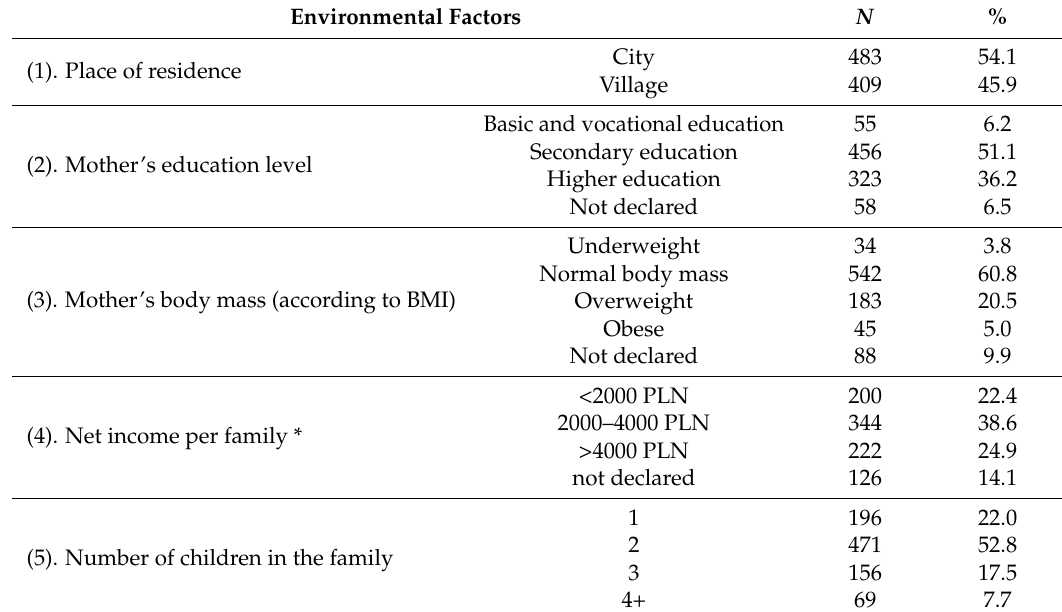
Table 1. Characteristics of the respondent sample ( N =